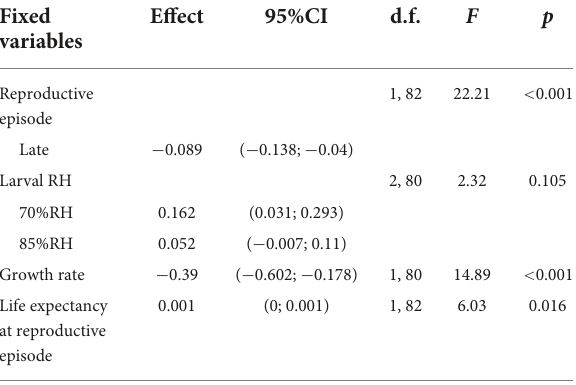
TABLE 2 Linear mixed model analyzing the reproductive investment (number of eggs per mg of body mass before the reproduction episode) of Tenebrio molitor